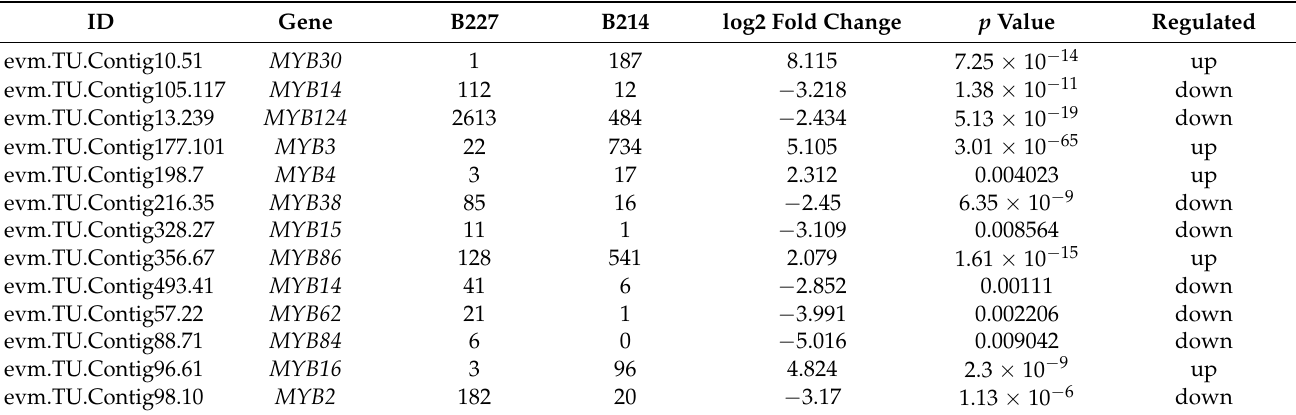
Table 5. Differentially expressed MYBs in the mature pericarp of B214 and